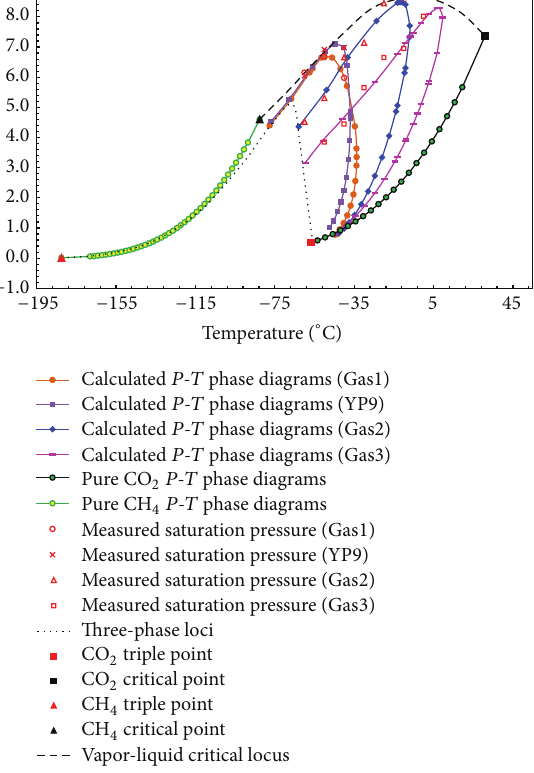
Figure 13: Calculated 𝑃 - 𝑇 phase diagrams and measured saturation pressure of natural gas with different CO 2 contents.